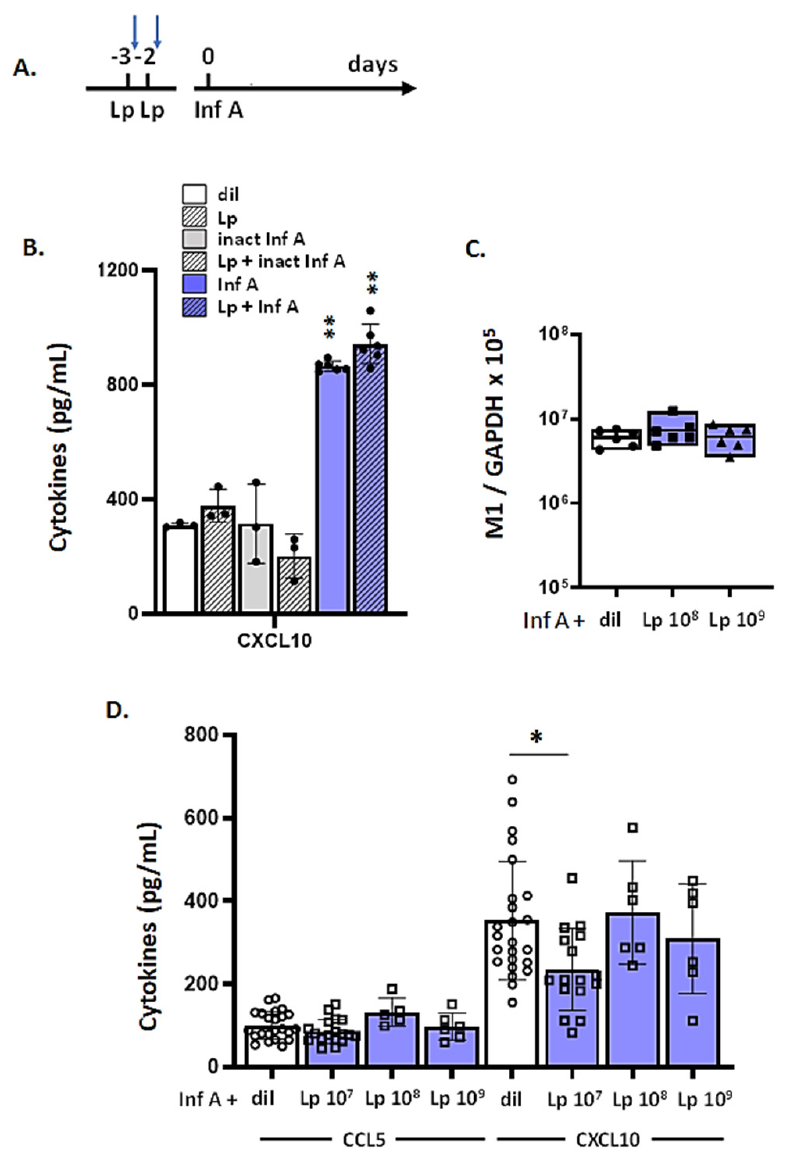
Figure 7. Treatment with Lp does not elicit cross-protection against virus-induced inflammation in either MLE-12 or mTEC cultures. ( A ) Experimental protocol. Cell cultures were treated with Lp or diluent control on days indicated followed by Inf A on day 0; blue arrows indicate extensive wash- ing at 2 h post-treatment. ( B ) Proinflammatory cytokines CCL5 and CXCL10 detected in culture supernatants from MLE-12 cells at 48 h after inoculation with live or heat-inactivated Inf A as in ( A ), ** p < 0.01 vs. diluent alone, one-way ANOVA. ( C ) Virus detected in mTECs pretreated with diluent or Lp (10 8 or 10 9 cells/mL) at 48 h after inoculation with live Inf A on day 0. ( D ) Proinflam- matory cytokines detected in supernatants of diluent or Lp-primed mTECs at 48 h after inocula- tion with live Inf A; * p < 0.05 vs. diluent alone, one-way